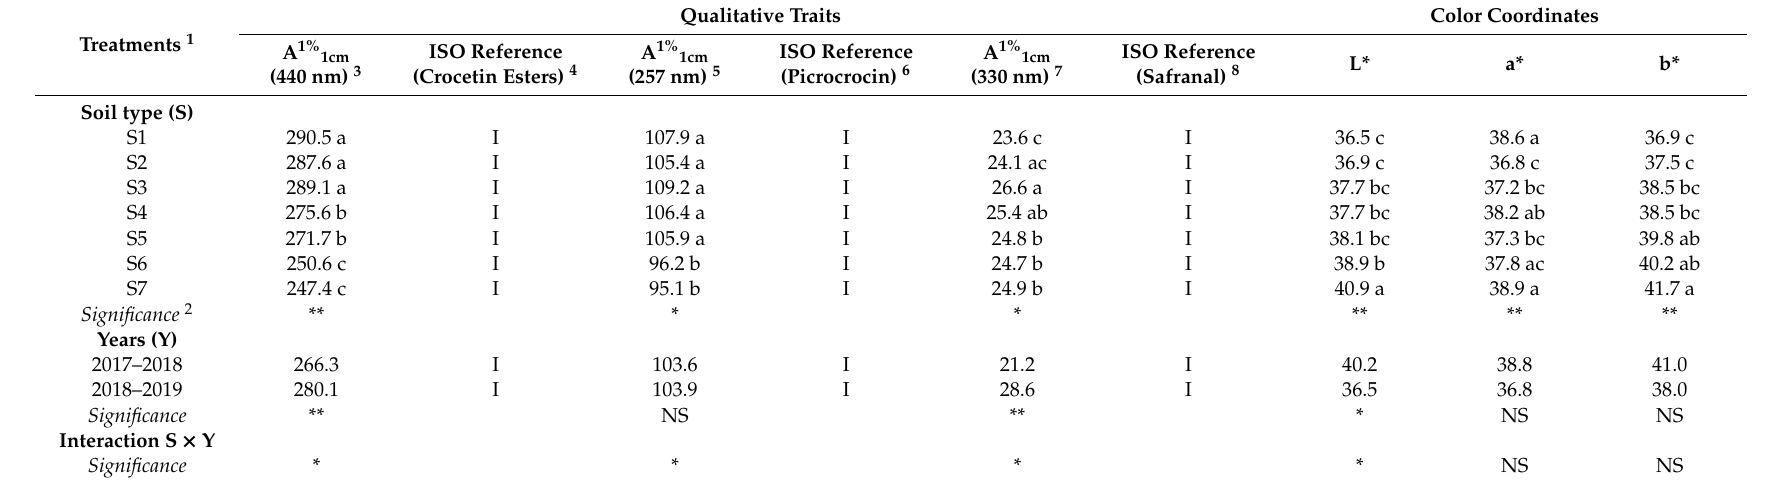
Table 4. E ff ects of the soil type on spice qualitative and colorimetric traits in two